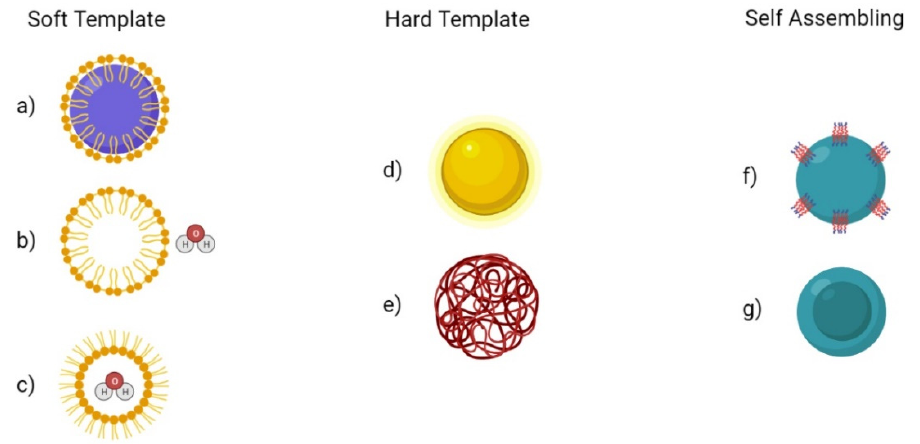
Figure 2. Fabrication methods for Hollow MSN (HMSN). ( a ) Dual surfactant soft template method ( b ) oil-in-water soft template method ( c ) water-in-oil soft template method ( d ) Metal and metal oxide hard template method ( e ) Polymer beads hard template method ( f ) Self-templating method of self-assembly ( g ) Selective-etching method of self-assembly.